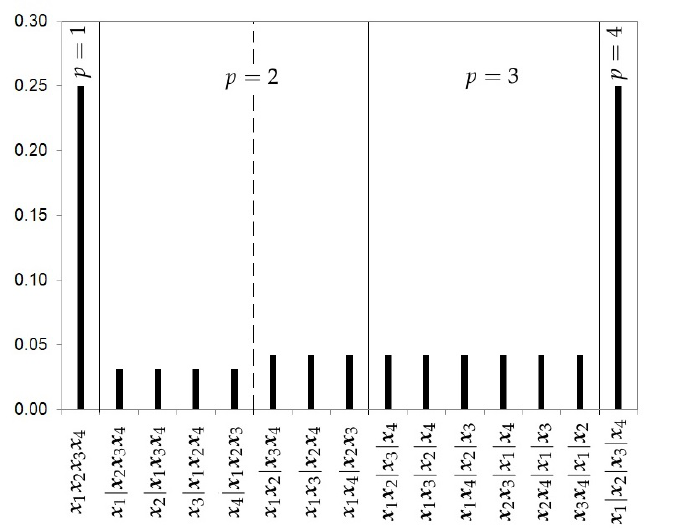
Figure 4. Hierarchical Uniform prior with 3 levels probabilities for the partitions with k = 4